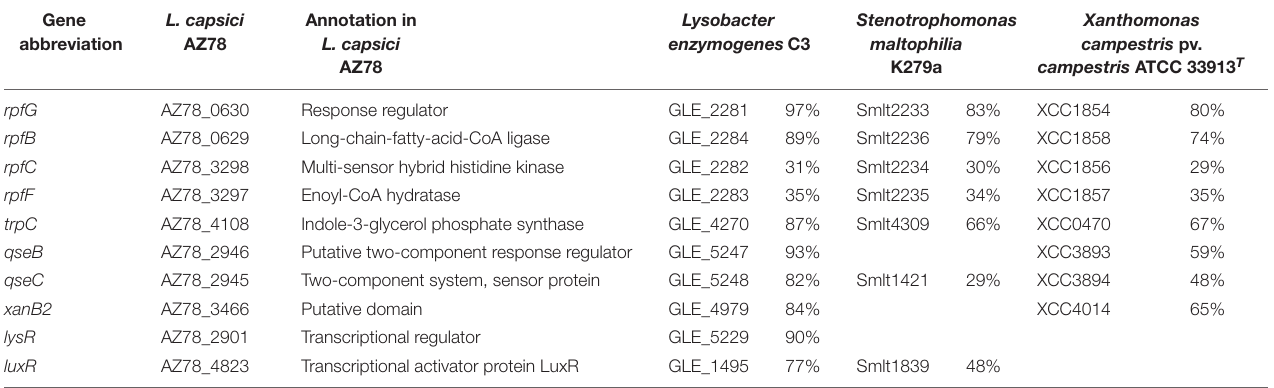
TABLE 1 | Cell–cell communication genes present in the genome of Lysobacter capsici AZ78.